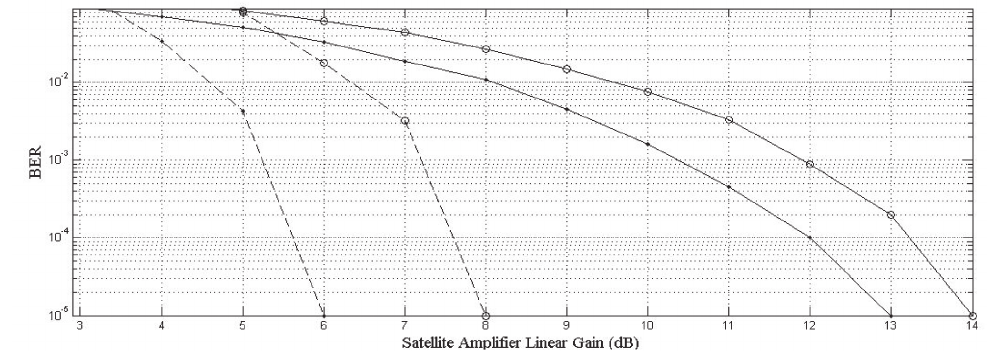
Fig. 7. Dependence of error probability for BPSK modulation scheme on satellite transponder linear gain: dots indicate values without coding, circles – with convolutional coding (rate ¾, constraint length K = 7); satellite and ground receivers noise temperatures is at 20 K (dots, free space path loss 162 dB) and at 290 K (circles, free space path loss 157 dB); phase and frequency offsets are equal to zero; HPAs nonlinearity is negligible; d 1 = d 2 = d 3 = d 4 = 1.0 m; satellite transponder phase noise is negligible Table. Dependence of Error Probability for BPSK Modulation Scheme on Amplifiers Nonlinearity HPA back-off level (Aircraft and Satellite)